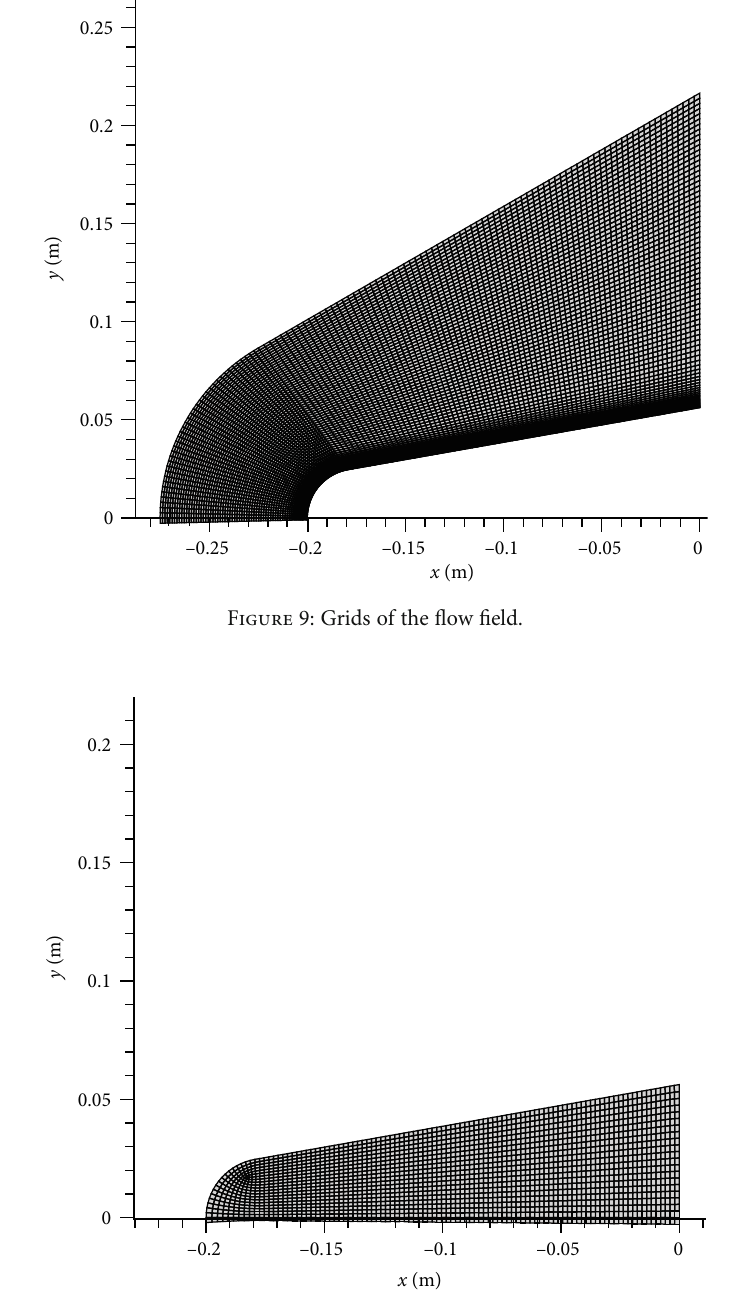
Figure 10: Grids of the carbon/carbon leading edge. Table 2: Di ff erent groups of